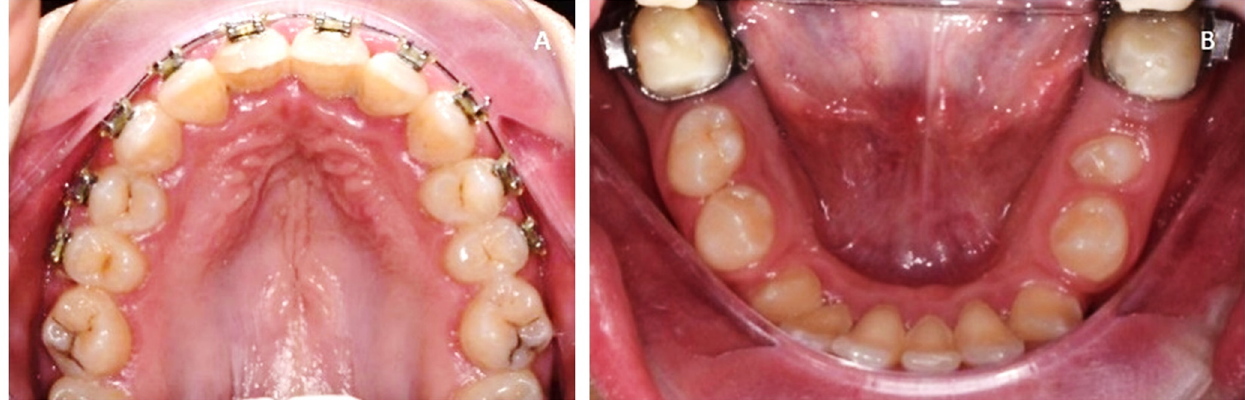
Figure 7. ( A ) Occlusal upper arch, ( B ) occlusal lower arch.